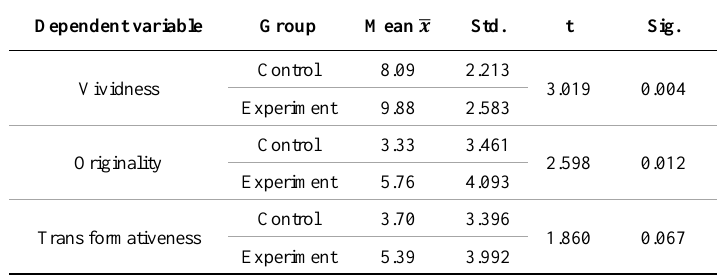
Table 7. The results of MANOVA analysis of Creative Imagination scores of three components in the experimental and